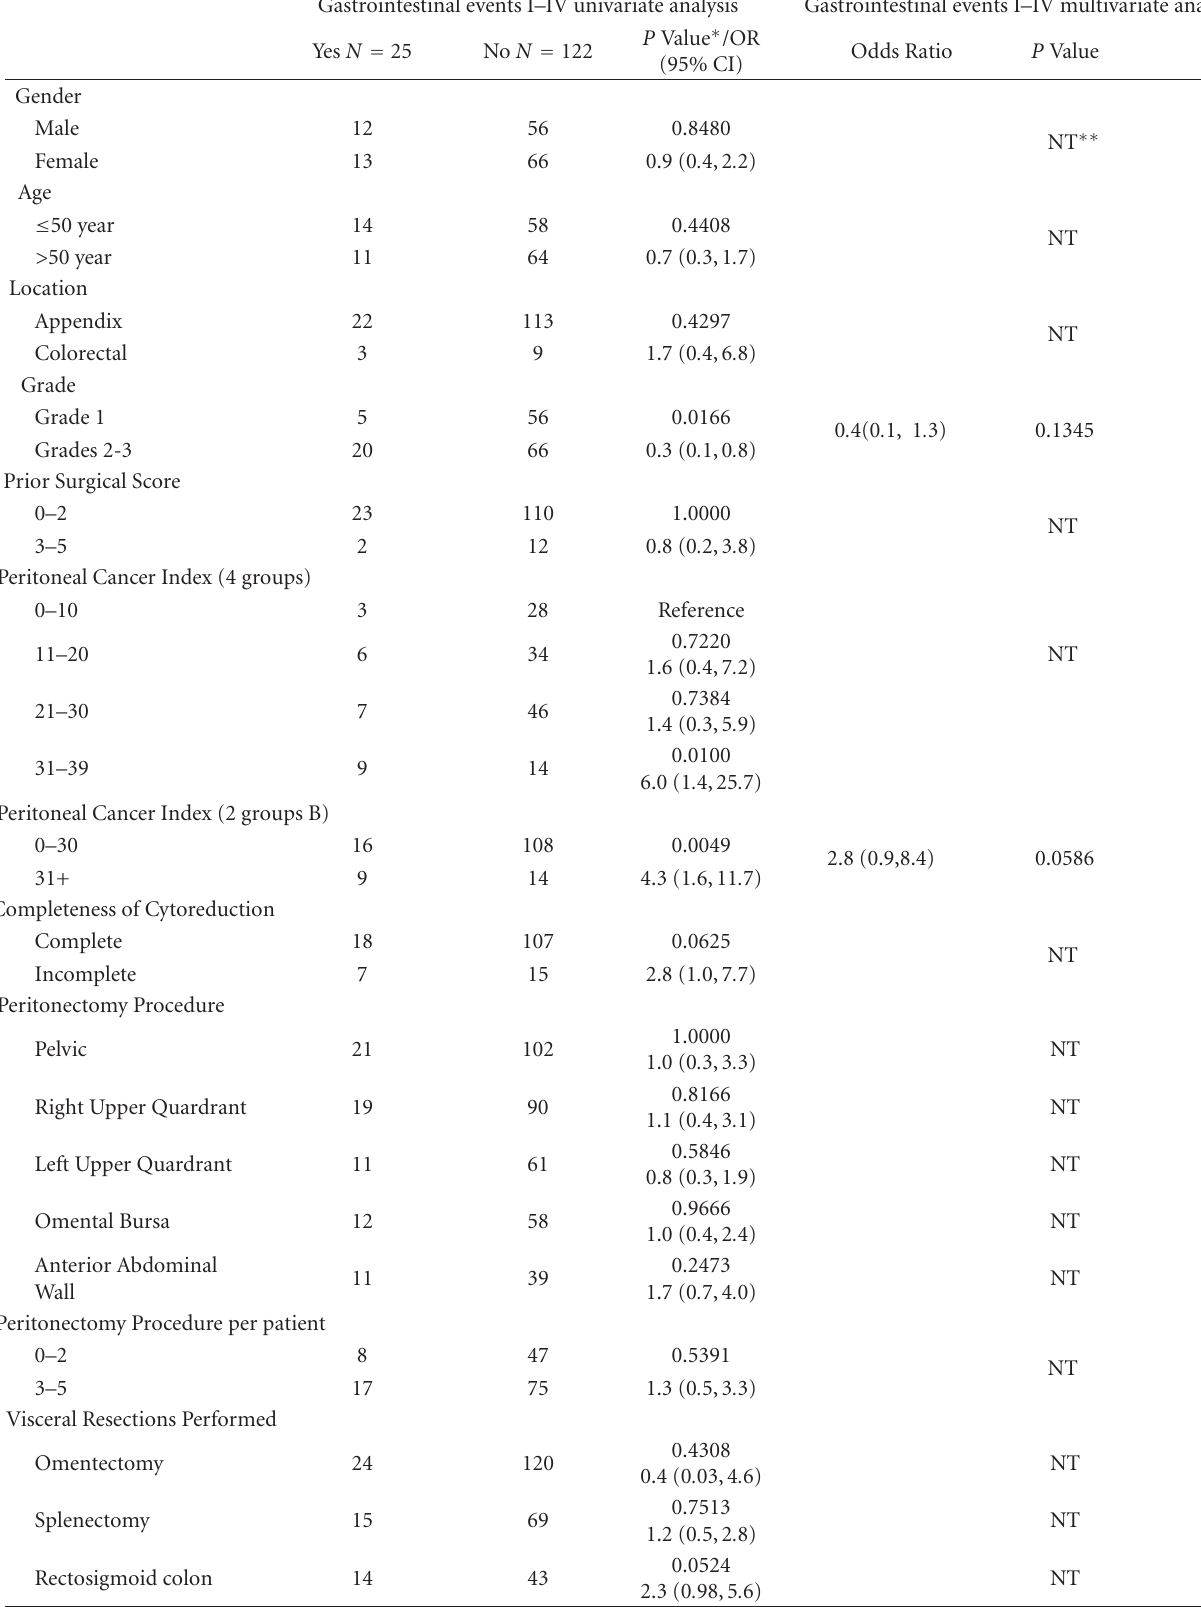
Table 3: Univariate and multivariate analysis (gastrointestinal